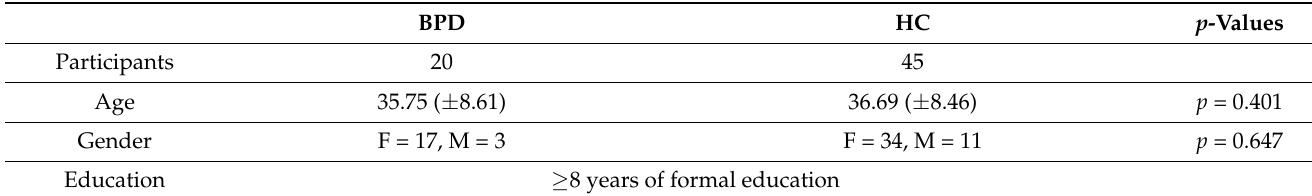
Table 1. Demographic data of the